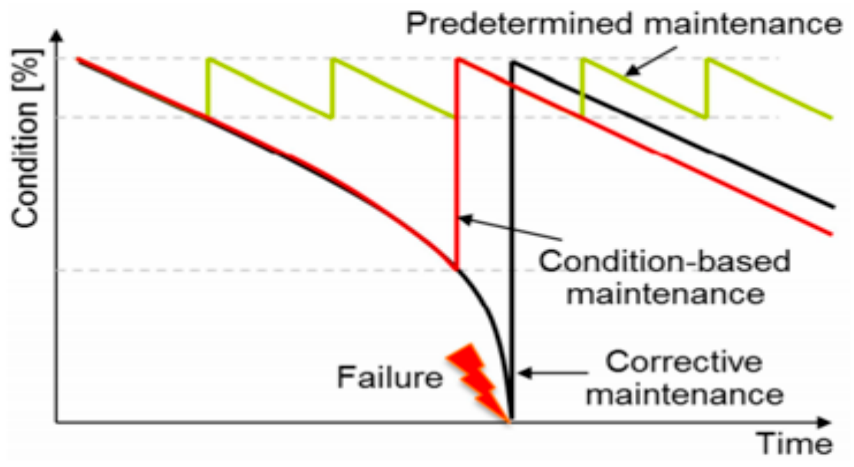
Figure 1. Influence of the maintenance strategy on the asset condition [10].